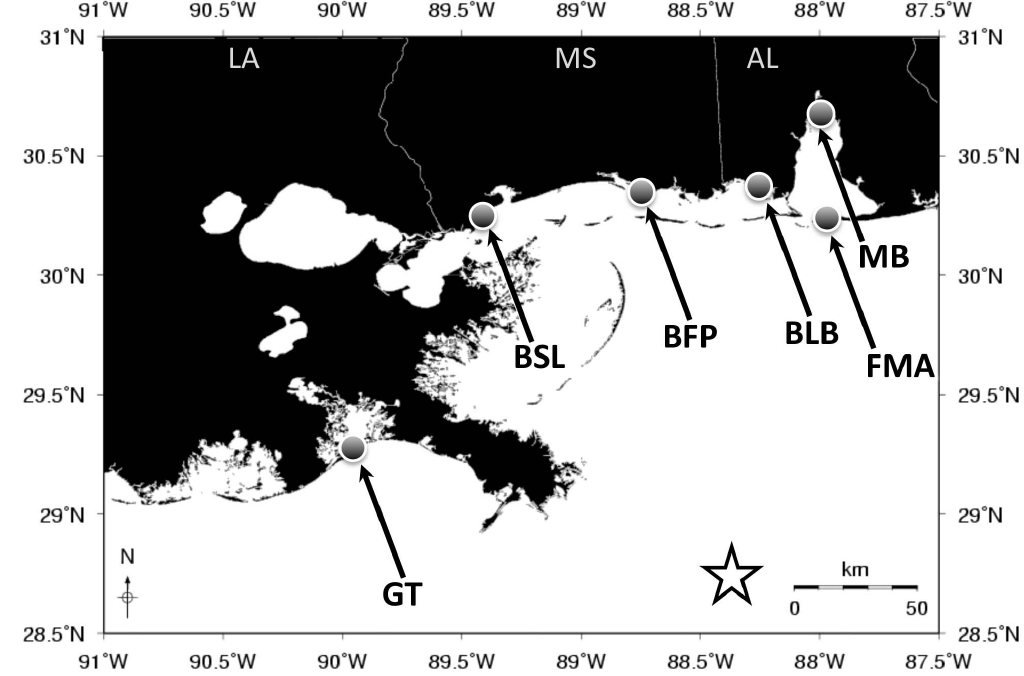
Figure 1. Location of the field study sampling sites from the experiments reported in Whitehead et. al, [20] . Location of field sampling sites, which include Grand Terre (GT), Bay St. Louis (BSL), Belle Fontaine Point (BFP), Bayou La Batre (BLB), Mobile Bay (MB), and Fort Morgan (FMA). The star indicates the DWH spill site.